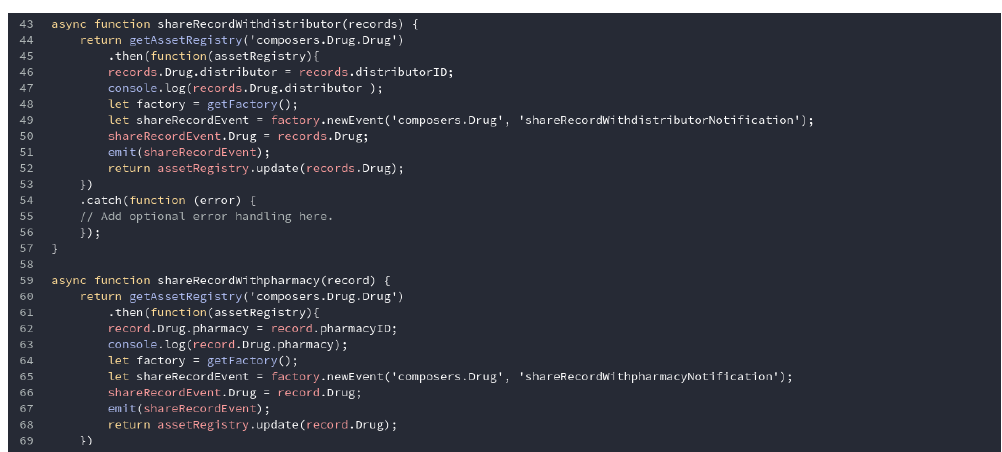
Figure 11. Smart contract definition in scripts file for a function update drug